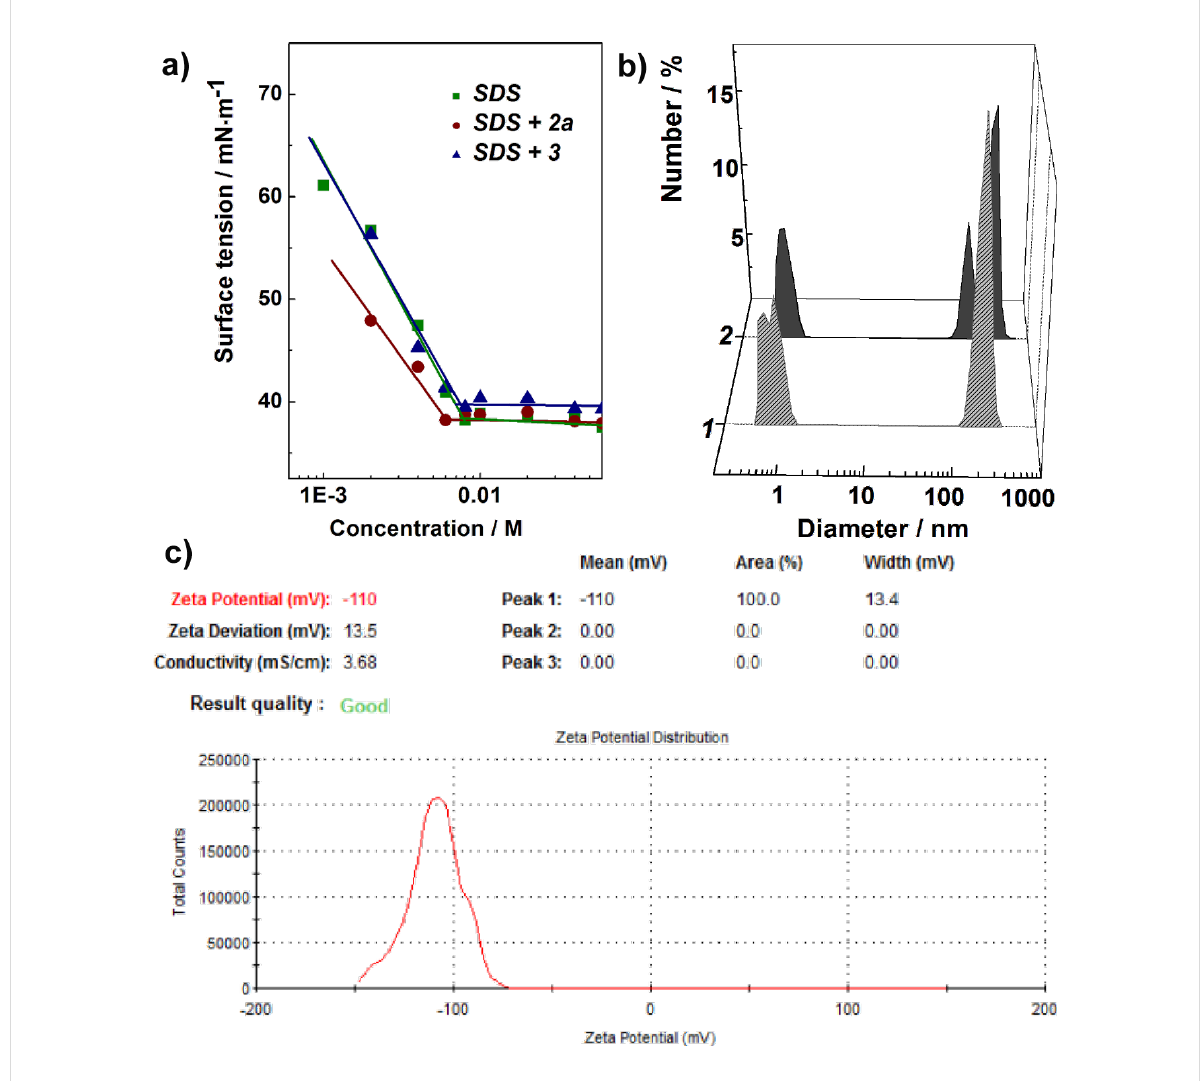
Figure 6: (a) Surface tension isotherms of SDS in the absence and presence of 2a and 3 in water, (b) Analysis of the size distribution and (c) zeta potential of 2a particles in water–SDS solutions, c SDS (mM): 60 (1), 80 (2), 25 °C.